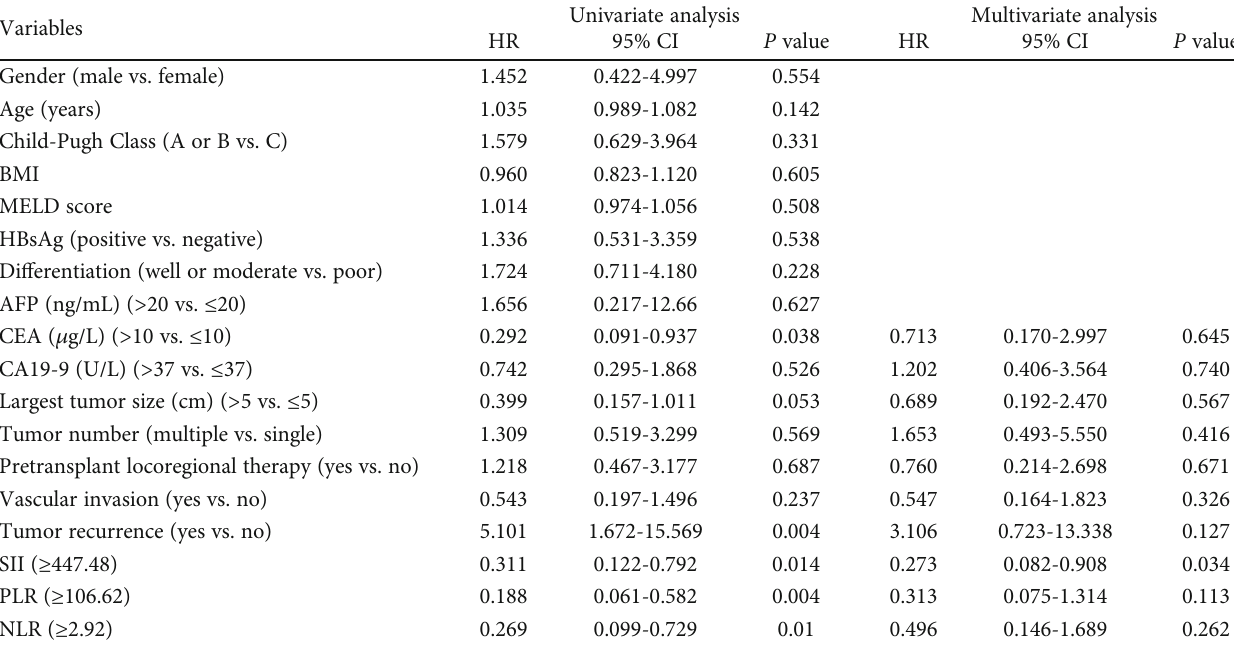
Table 3: Univariate and multivariate analyses of factors related to overall survival in patients with iCCA who underwent LT.